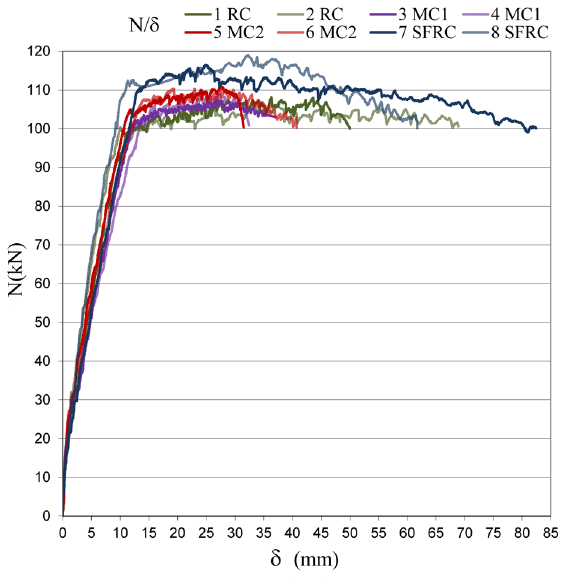
Fig. 2. Load-deflection curves of the eight tested